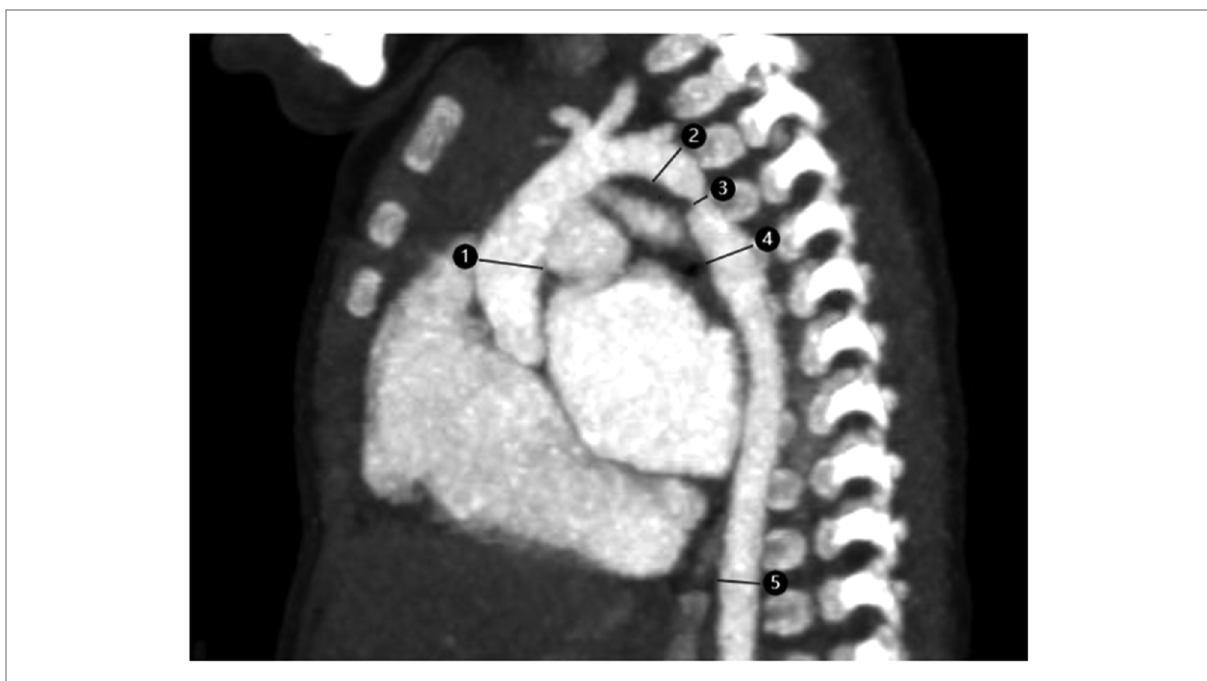
FIGURE 1 Ct image of aortic coarctation in a 2-month-old infant. 1. ascending aorta; 2. pre-coarctation aorta; 3. site of coarctation; 4. post-coarctation aorta; 5. descending aorta at level of